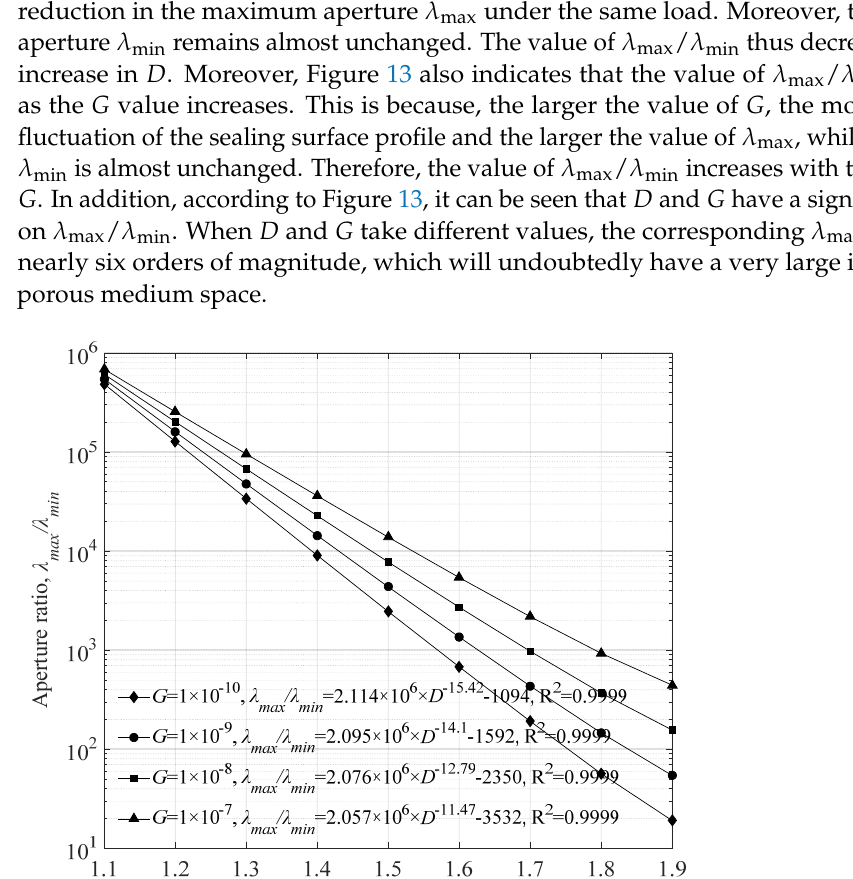
Figure 14. The influence of fractal parameters of sealing surface on the fractal dimension of pore space.